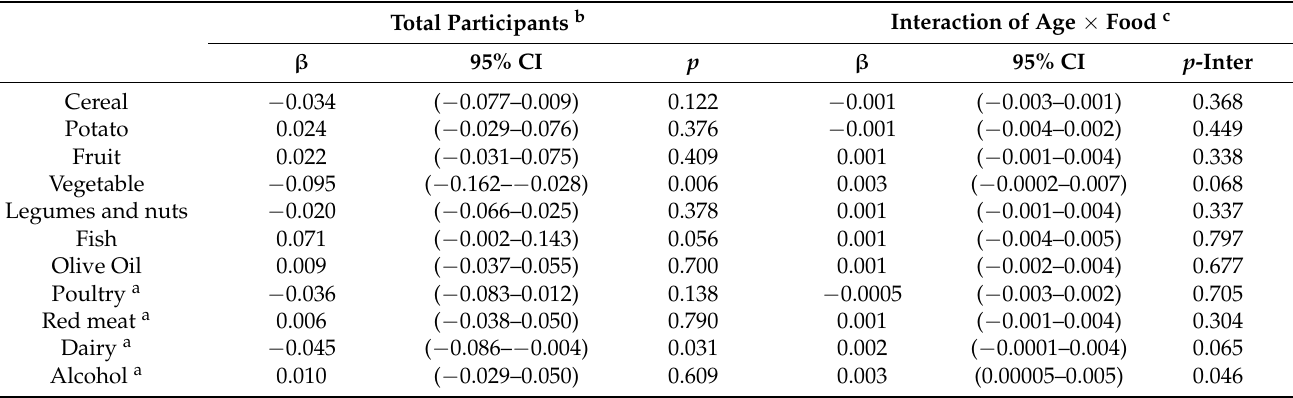
Table 3. Association between individual food category and the change in white matter hyperinten- sity